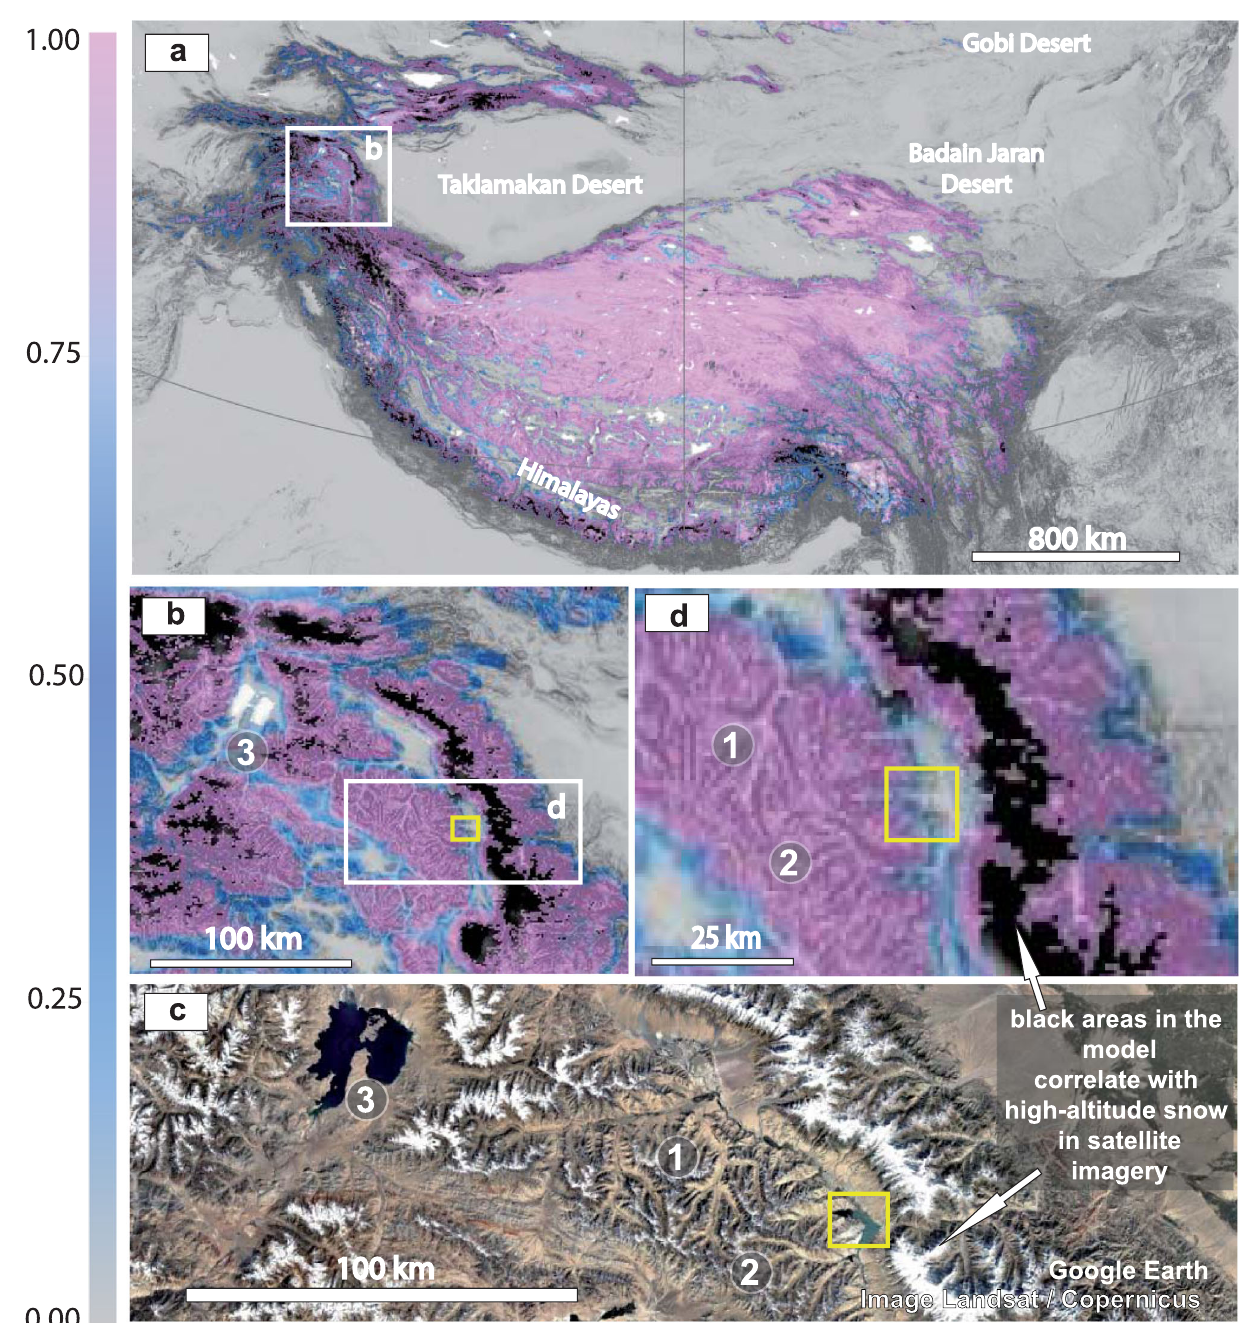
Fig.5|Permafrostprobabilityfraction(PERPROB)mapsofmodernpermafrost distributionintheHimalayan – TibetPlateauregion.a , b ,and d Mapsproducing by combining a DEM with Permafrost Probability Fraction (PERPROB) data from refs. 42,43 https://doi.pangaea.de/10.1594/PANGAEA.888600?format=html#